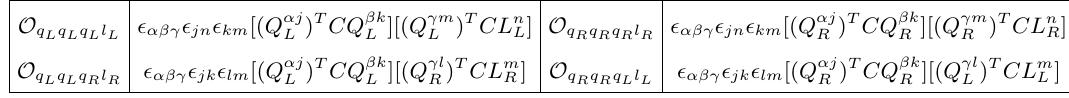
Table 20. MLRSM: Baryon Number Violating 4 [4 a distinct Hermitian